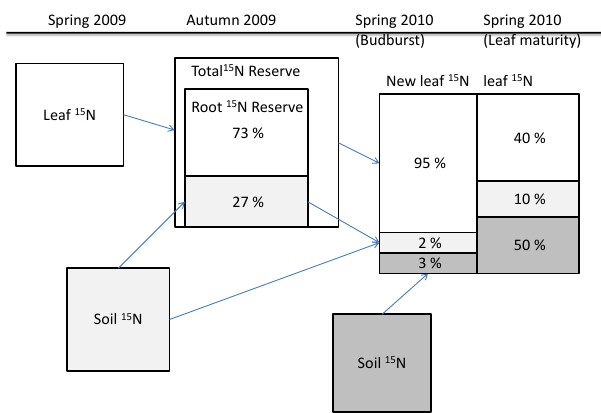
Figure 4. Conceptual scheme representing percentage contributions of 15 N (Eq. 2) from each labelling campaign (L 1 : white, L 2 : light grey, L 3 : dark grey) in roots in the autumn and in new leaves in the season following the first labelling